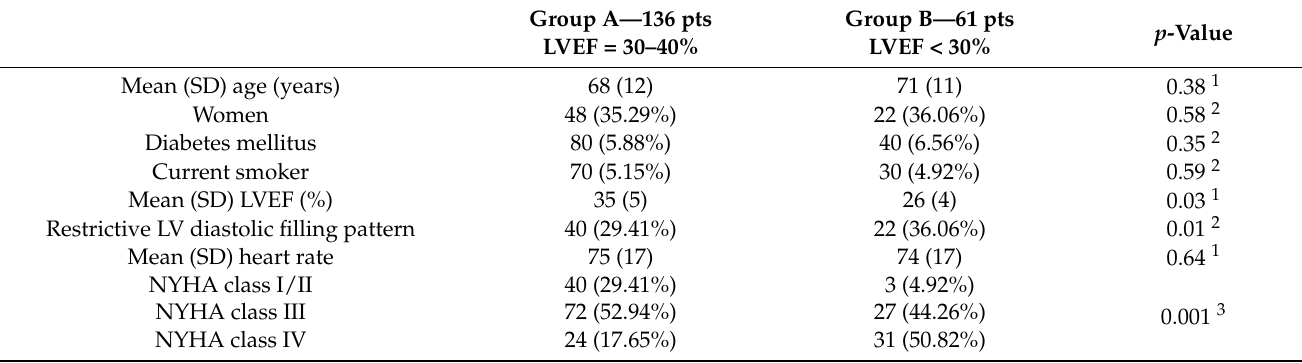
Table 1. Baseline patient